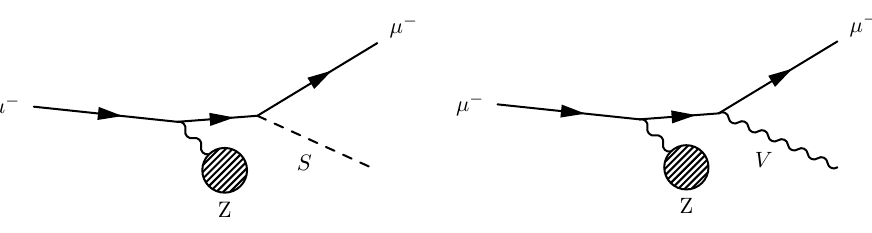
Figure 1 . Dark bremsstrahlung signal process for simplified models with invisibly decaying scalar ( left ) and Figure 4 . Radiative singlet production via coherent muon-nucleus scattering at muon beam fixed vector ( right ) forces that couple predominantly to muons. In both cases, a relativistic muon beam is incident target experiments M 3 [92], NA64 µ [93], and proposed beam dump searches on a fixed target and scatters coherently o ↵ a nucleus to produce the new particle as initial- or final-state radiation.